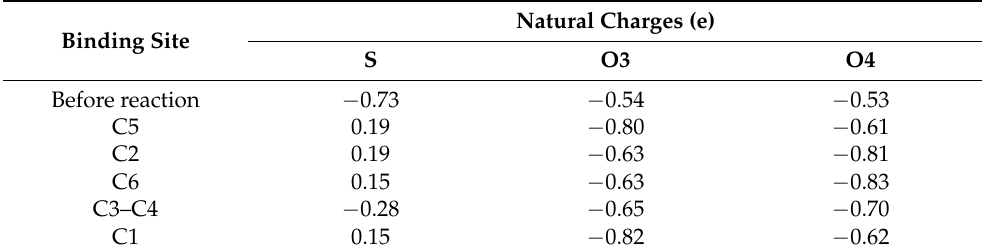
Table 2. Natural charges on cysteinyl sulfur and quinonic oxygens during the formation of Cys–S − - DQ